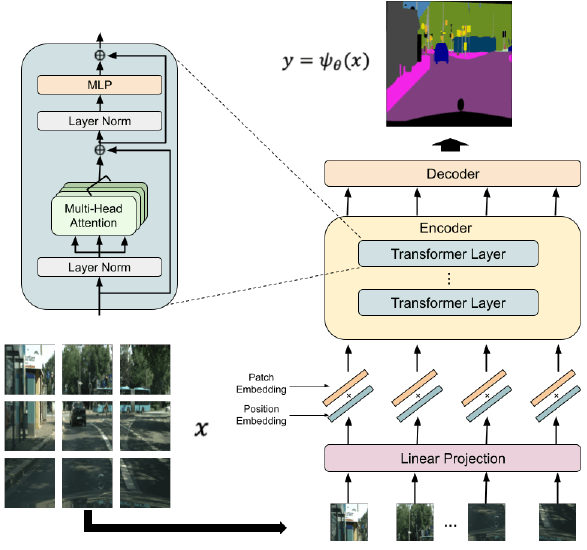
Figure 2. Architecture of segmentation transformer [17].